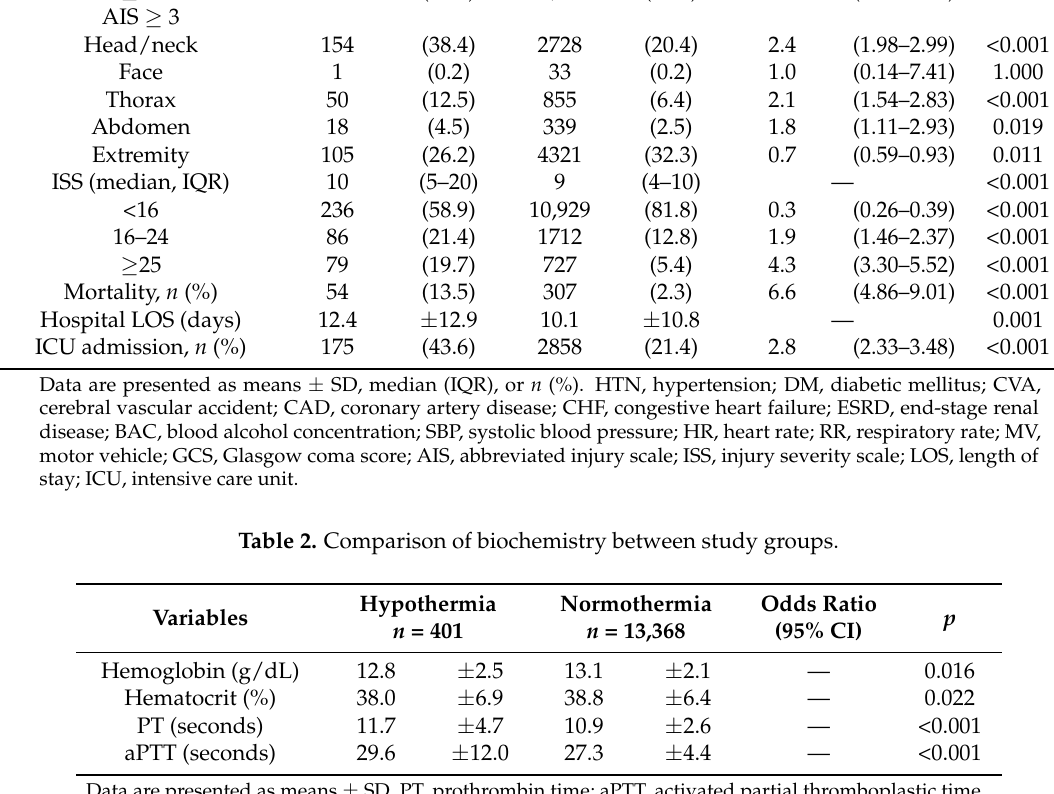
Table 3. Correlation of biochemistry to temperature in study population.